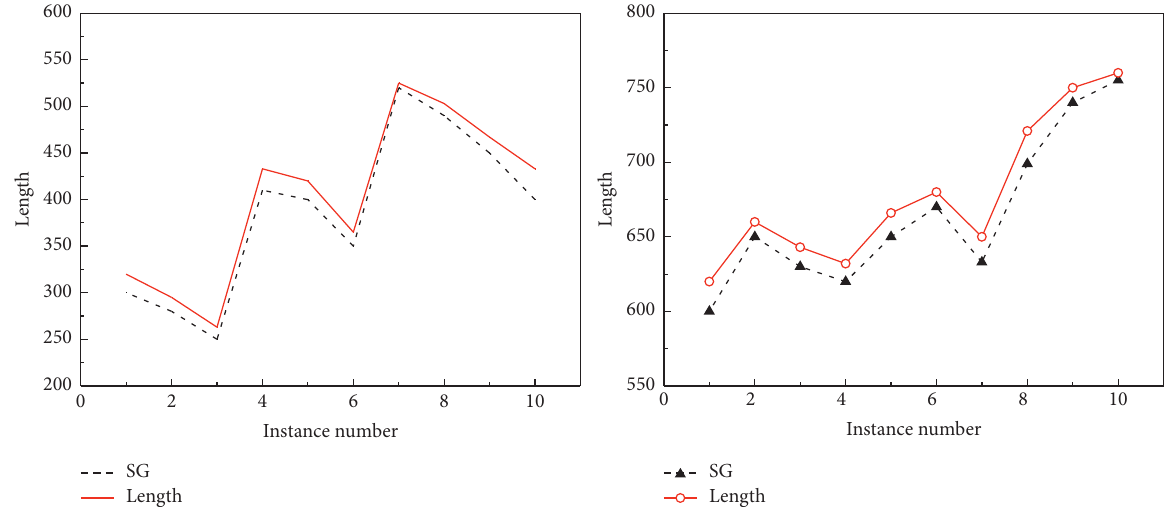
Figure 9: Comparison of predicted and actual values of e-commerce path optimization by genetic